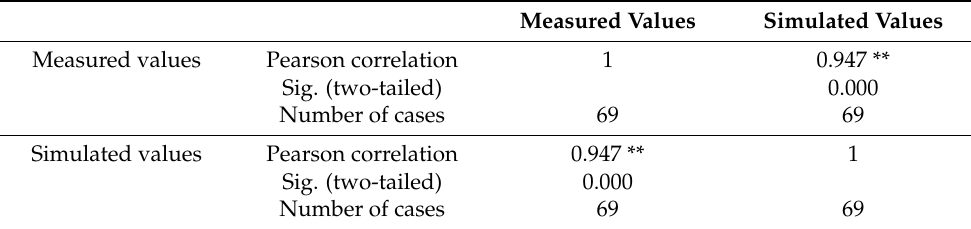
Table 1. Pearson two-tailed analysis table of simulated and measured values.